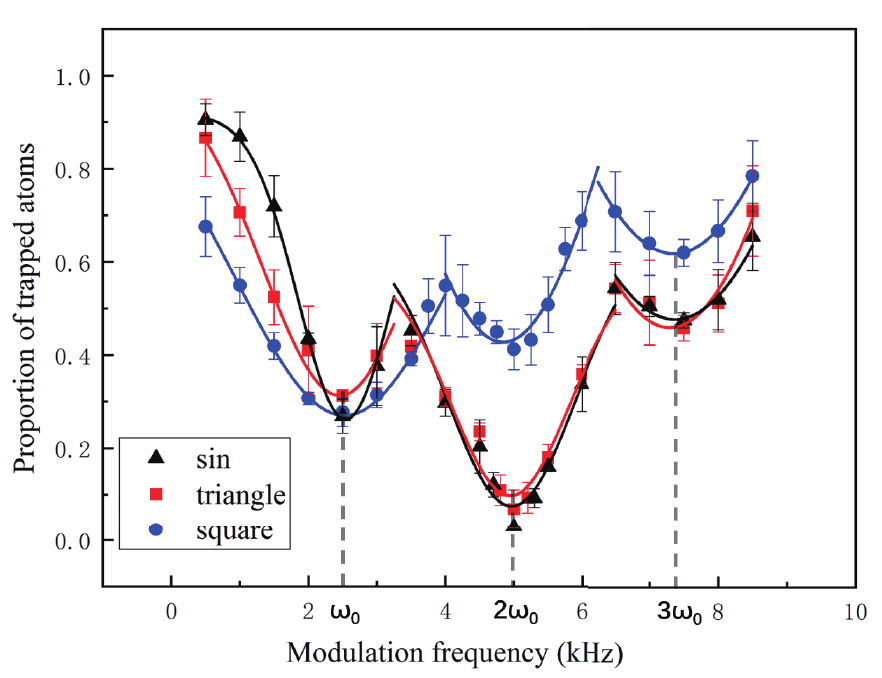
Figure 3. The experimental spectrum of the losses associated to parametric excitation of the ODT modulated by a sine wave (black data), a triangle wave (red data) and a square wave (blue data). The modulation depth is 0.15. Gaussian fits were used to determine the resonance center position. The measured resonance positions are 2.47 ( ± 0.19) kHz, ∼ 4.89 ( ± 0.15) kHz and ∼ 7.31 ( ± 0.27) kHz, corresponding to the frequencies of ω 0 , 2 ω 0 , and 3 ω 0 , respectively.